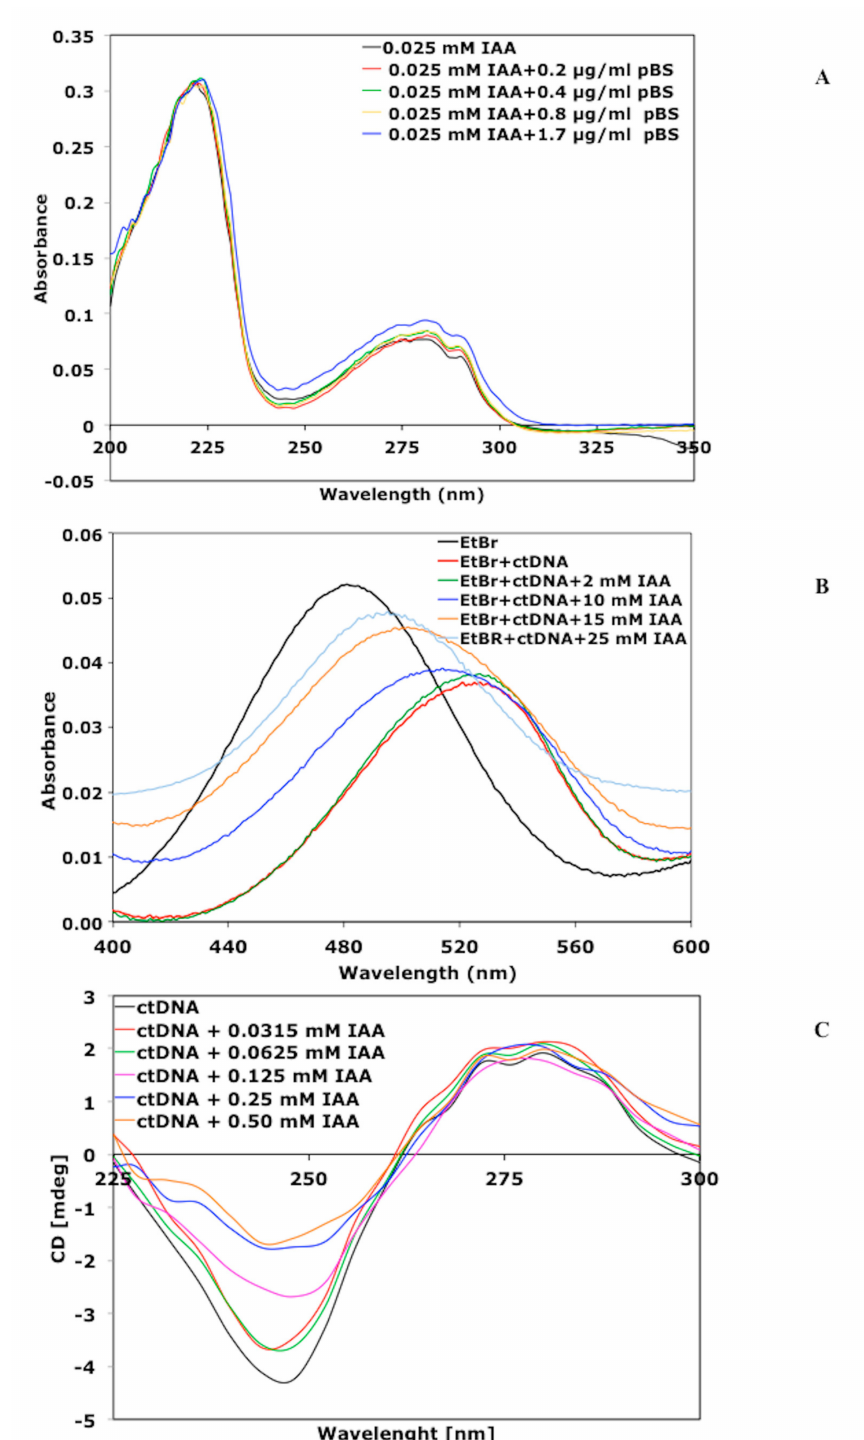
Figure 3. IAA alters the DNA structure. ( A ) UV absorption spectra of IAA (25 µ M) with increasing amounts of pBlueScript (pBS) plasmid. Appropriate mixtures of ethanol bu ff er and pBS plasmid were used as reference and subtracted from each measurement. ( B ) UV-Vis absorbance spectra of ethidium bromide (EtBr) (7 µ M) in absence (black line) and presence (blue line) of calf thymus DNA (ctDNA). The absorption spectra of the EtBr–ctDNA complex in the presence of increasing concentrations of IAA (2, 10, 15, 25 mM) were also reported. ( C ) Circular dichroism spectra of ctDNA (125 ng mL − 1 ) in the presence of increasing concentrations of